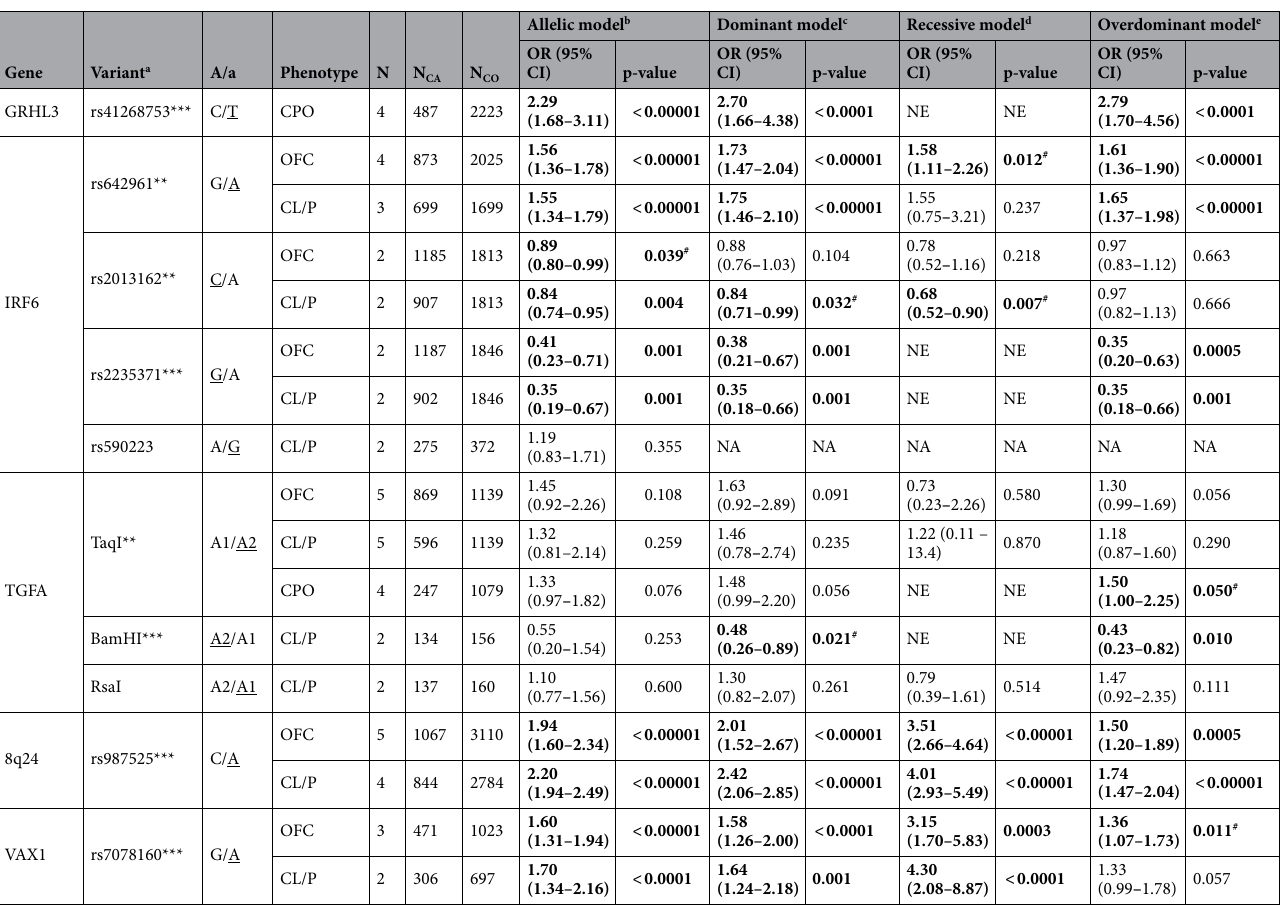
Table 1. Results of the meta-analysis performed to determine the associations between the genetic markers and the different non-syndromic orofacial cleft phenotypes in populations of European ancestry; results for the genes where there were significant associations with large effect sizes. A/a, major and minor alleles, where major allele is listed first and risk allele is underlined; Phenotype, non-syndromic orofacial cleft phenotype studied (CL/P, cleft lip with or without cleft palate; CPO, cleft palate only; OFC, all phenotypes combined); N, number of studies included in the analysis (allelic model); N CA , total number of cases included in the analysis (allelic model); N CO , total number of controls included in the analysis (allelic model); NA, not available; NE, not estimable; OR (95% CI), pooled odds ratio with 95% confidence interval for each analysis. Abbreviations of gene names are given in Supplementary Table S4 and further details about the meta-analysis are presented in Supplementary Table S6. *Significant results with large (***) and moderate (**) effect sizes; the largest values for the variant were considered, regardless of the phenotype studied or genetic model used. # Results that did not remain significant after applying Bonferroni correction. a Genetic variants found in named genes or in their close proximity; listed based on chromosomal location; b minor allele (a) vs. major allele (A); c Aa + aa vs. AA; d aa vs. Aa + AA; e Aa vs. AA + aa. Statistically significant results are in